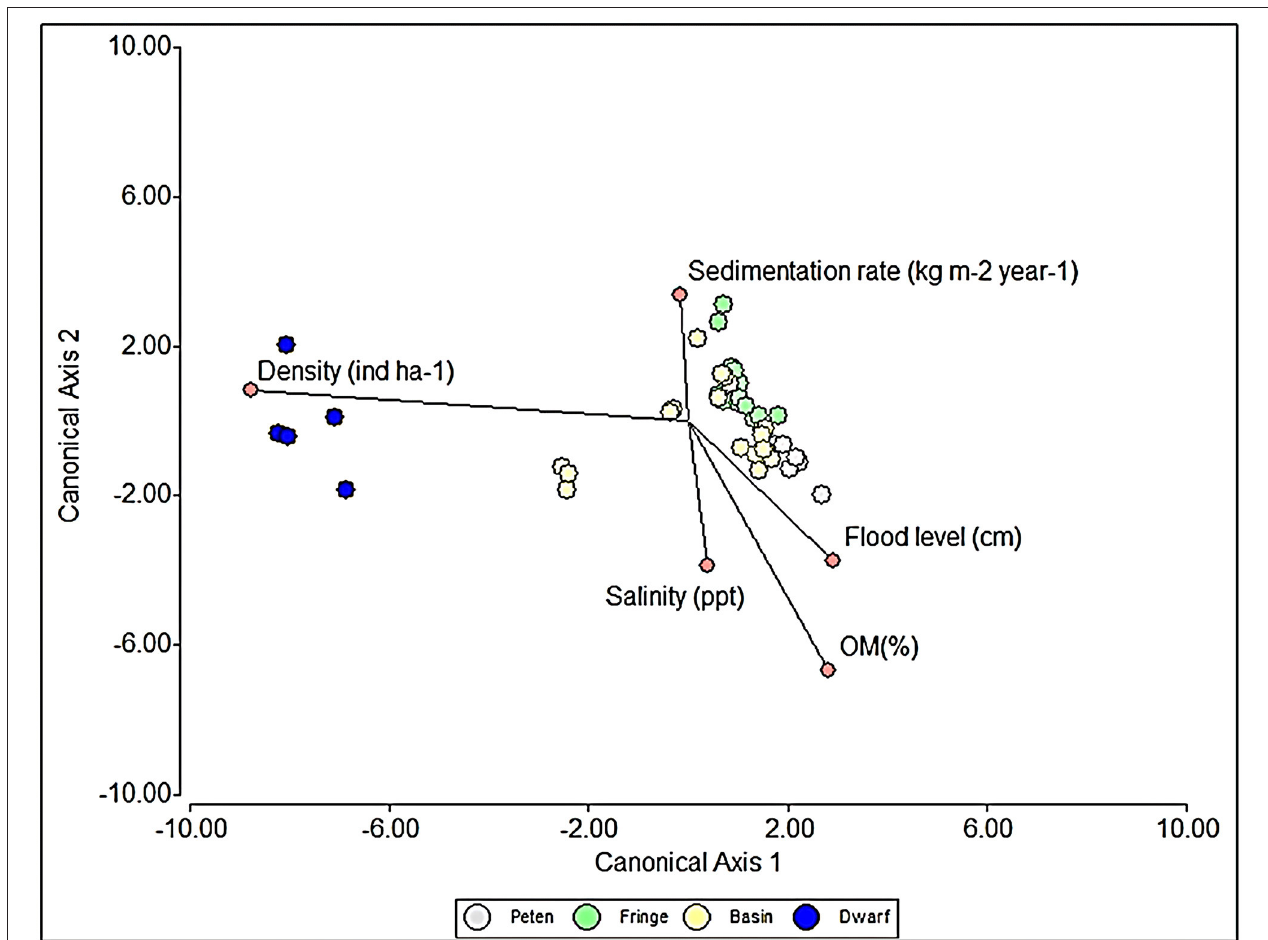
FIGURE 4 | An LDA. The distribution of sampling sites in four ecological types of mangroves (fringe, basin, dwarf, and peten), according to the density of trees, salinity, flood level, organic matter content, and sedimentation rate. meteorological phenomena frequency along the coast during this